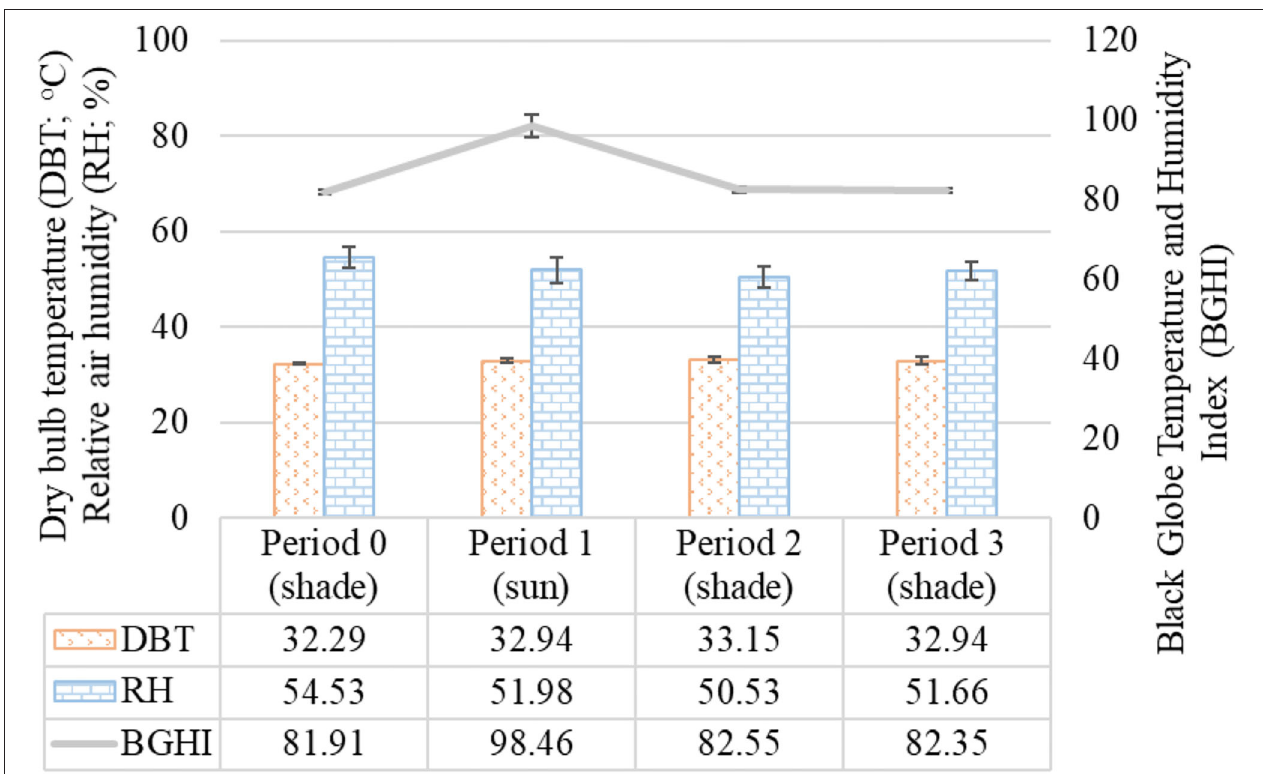
FIGURE 2 | Mean and standard deviation of the biometeorological variables recorded in different observation periods during the HTT carried out in adult female buffaloes in humid tropical climate. Period 0 (shade): From 10a.m. to 12 p.m.; Period 1 (sun): From 12 p.m. to 1 p.m.; Period 2 (shade): From 1 p.m. to 2 p.m.; Period 3 (shade): From 2 p.m. to 3